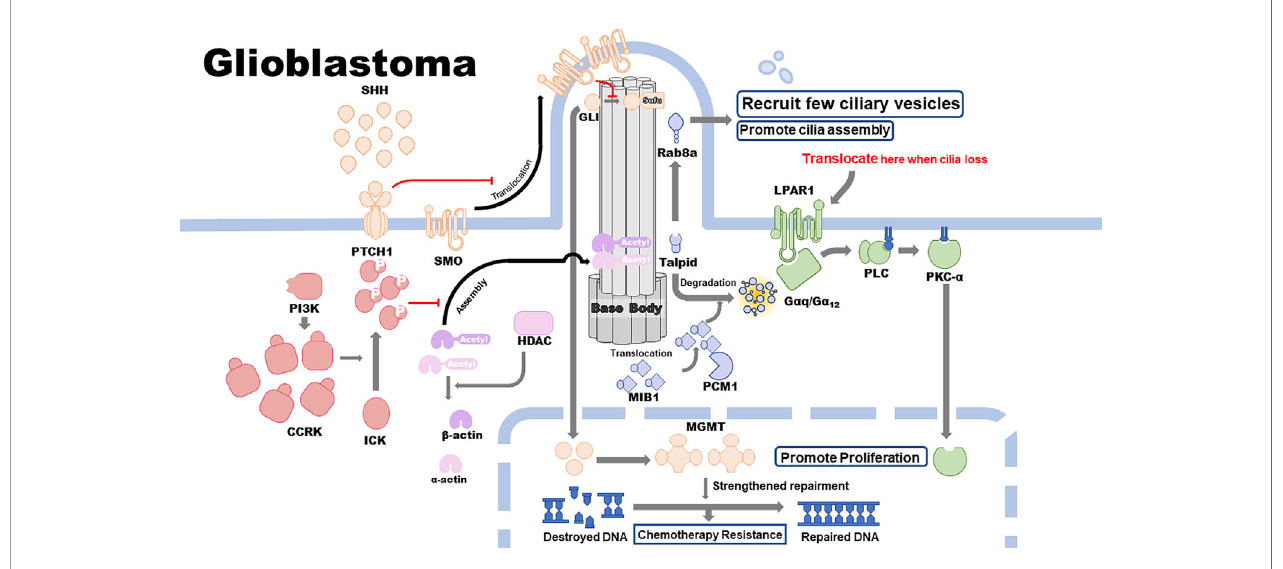
FIGURE 2 | Cilia-related pathways in glioblastoma (GBM)